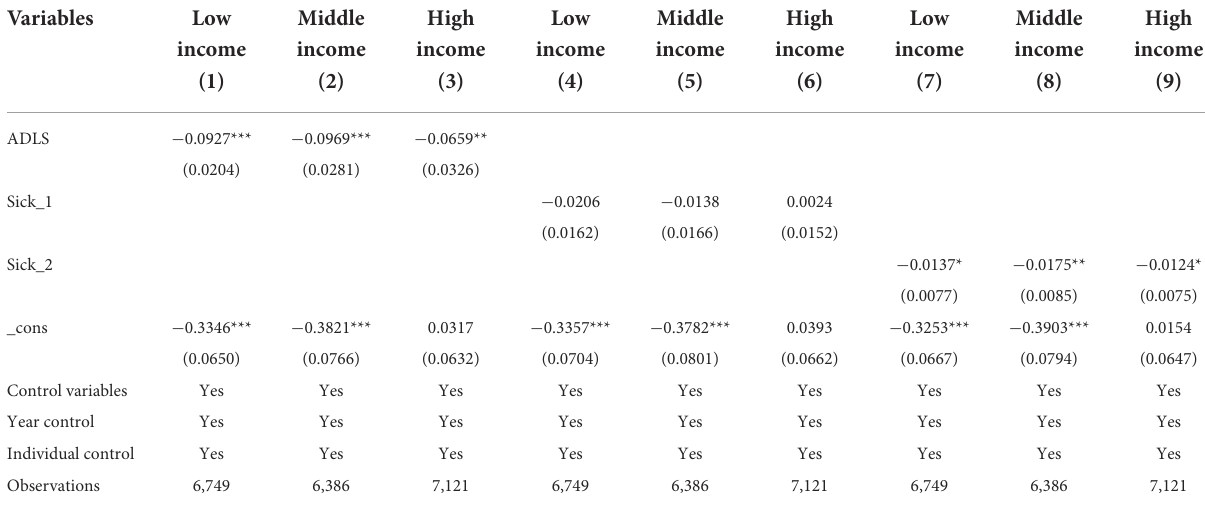
TABLE 5 Results of income